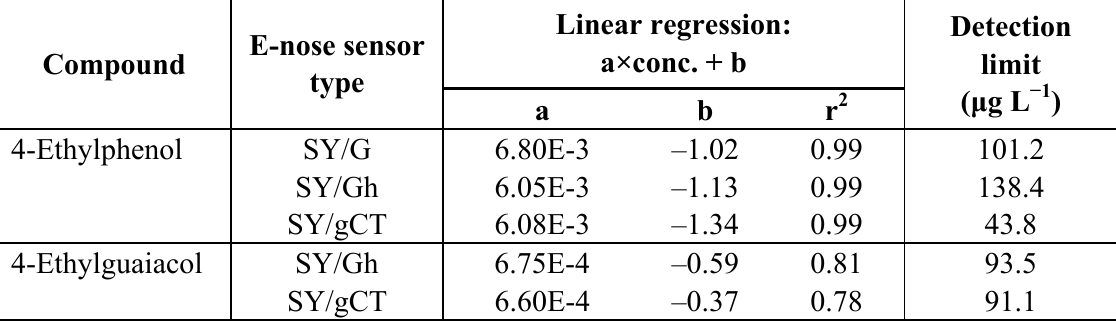
Table 2. Equations of the Linear Regression for the Different Compounds with Correlation Coefficient r 2 and detection limit of the linear range (reprinted with permission from [79]; copyright 2008 American Chemical